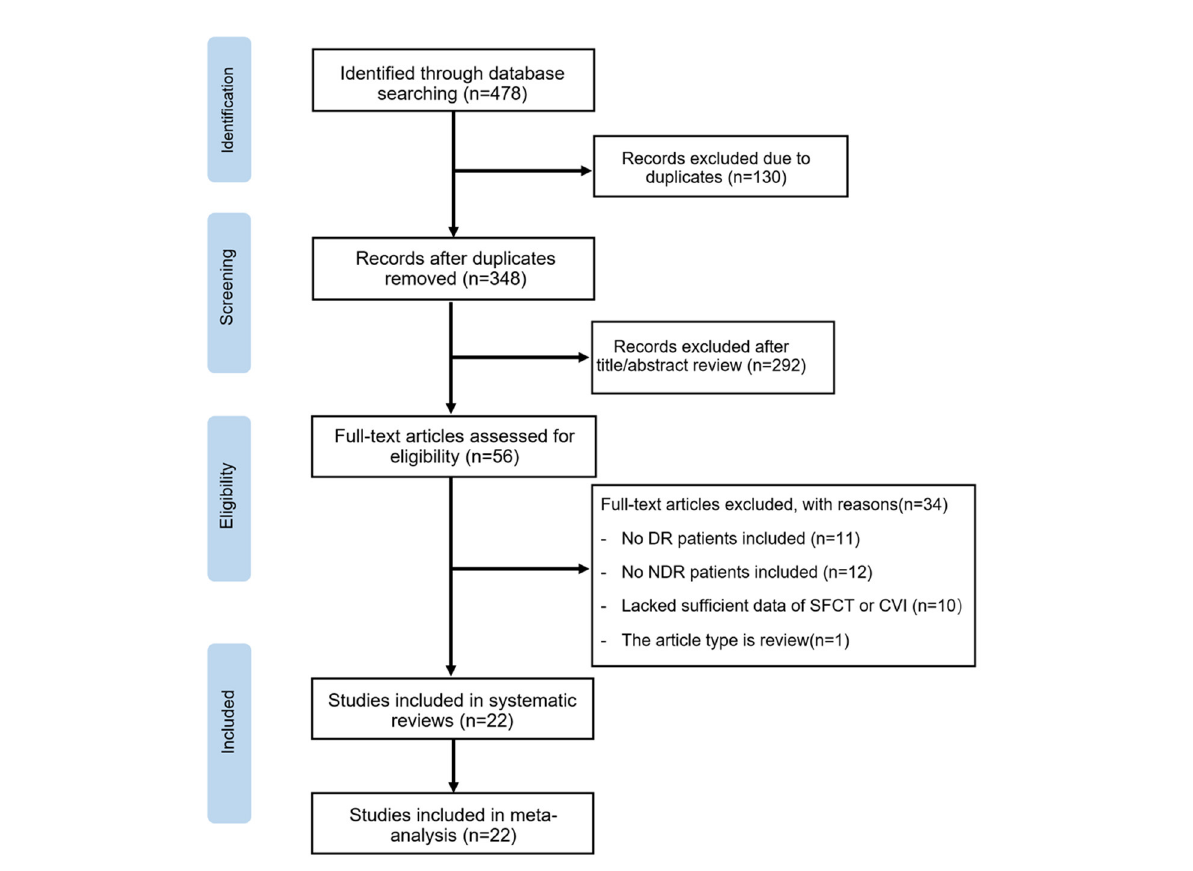
FIGURE1 PRISMA flow diagram of the literature search